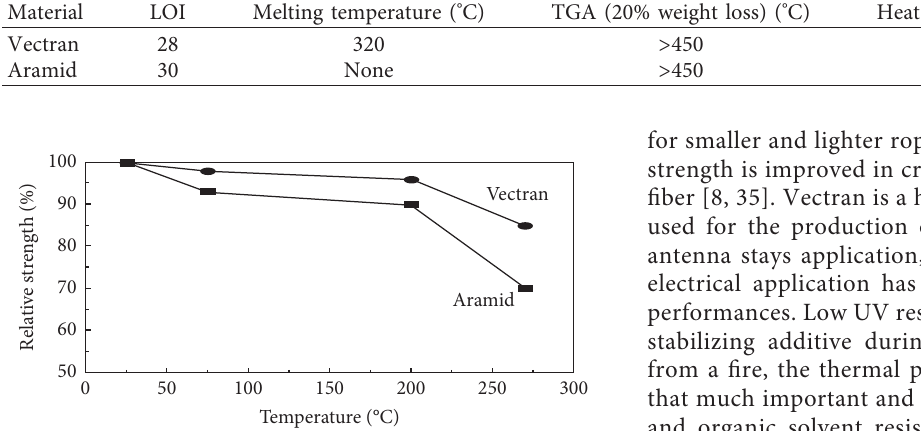
Figure 3: Relative strength in four-day thermal exposure of Vectran and aramid/fiber [9].